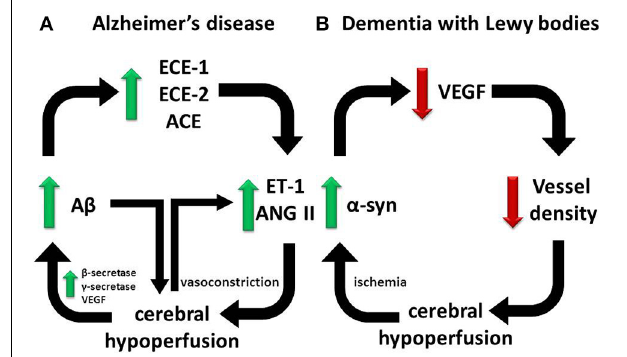
FIGURE 2 | Divergent pathways responsible for cerebral hypoperfusion in dementia. Our observations on human post-mortem brain tissue suggest that (A) in AD, cerebral hypoperfusion is mediated in part by elevated ECE-1/-2 and ACE in the cerebral cortex in AD in response to accumulating A β , whereas (B) in DLB, cerebral hypoperfusion is mediated by reduced vessel density in association with a reduction in VEGF expression, possibly in response to α -syn accumulation mediated by ischemia. In each pathway a vicious cycle ensues that accelerates disease